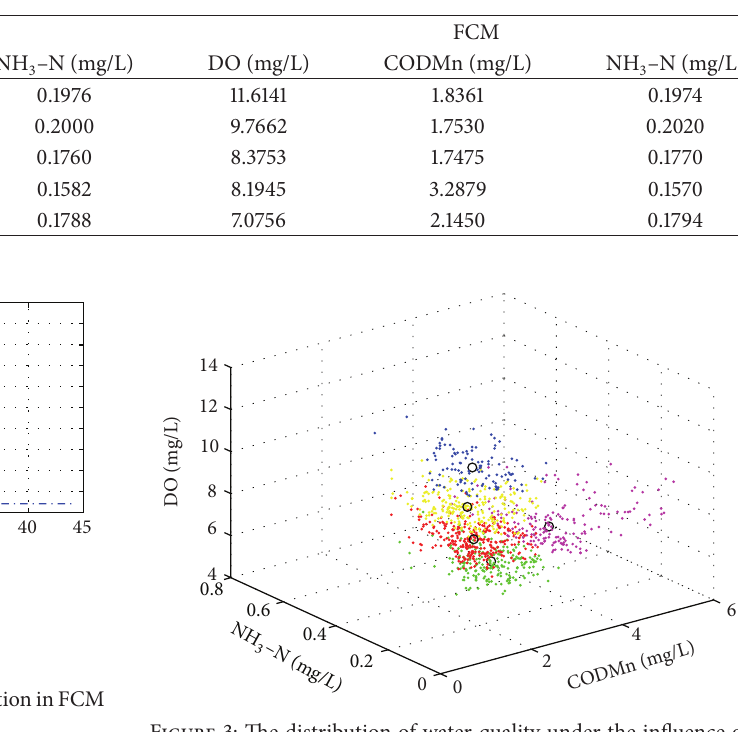
Figure 3: The distribution of water quality under the influence of CODMn, NH 3 –N, and DO.